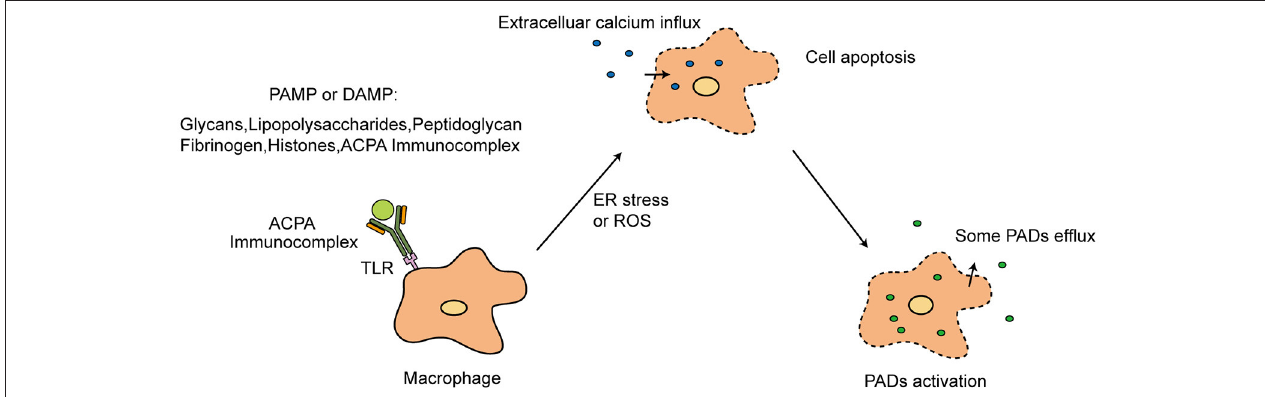
FIGURE 2 | PAMP or DAMP in PADs activation. TLR, toll-like receptors; PAMP, pathogen associated molecular pattern; DAMP, Damage-associated molecular patterns; ER, Endoplasmic reticulum; ROS, reactive oxygen